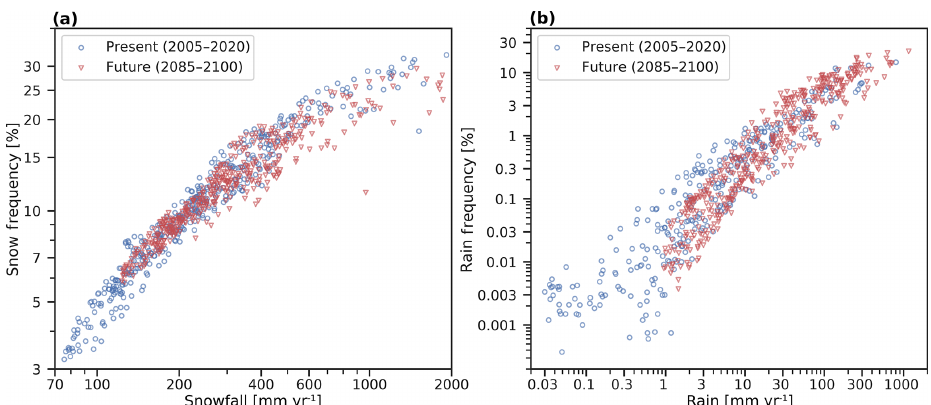
Figure 12. CESM-simulated snowfall frequency (a) and rainfall frequency (light rain only, b ) versus CESM simulated snowfall and rainfall rates in the present (2006–2020, blue circles) and future (2080–2095, red